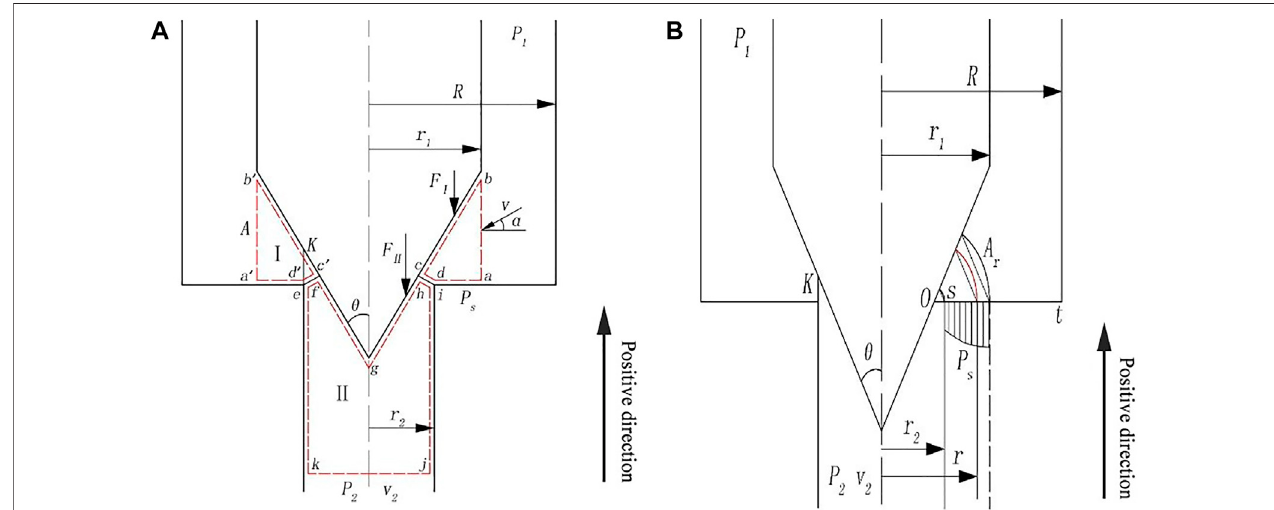
FIGURE 1 | Schematic diagram of control valve: (A) control volume; (B) pressure distribution at the